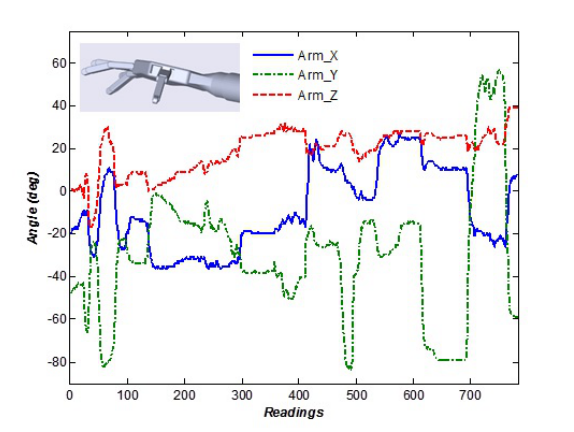
Figure 11: Arm rotation around x , y , and z